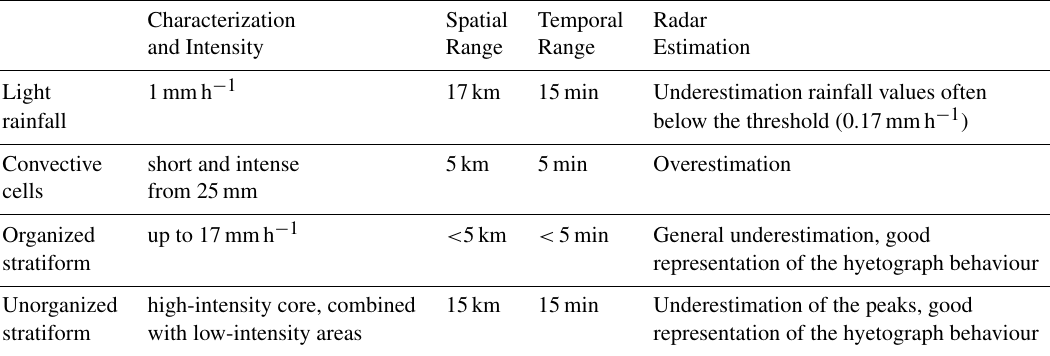
Table 3. Characterization of rainfall events, spatial and temporal scales, and rainfall estimation uncertainty. From van de Beek et al. (2010), Smith et al. (1994), and Emmanuel et al.